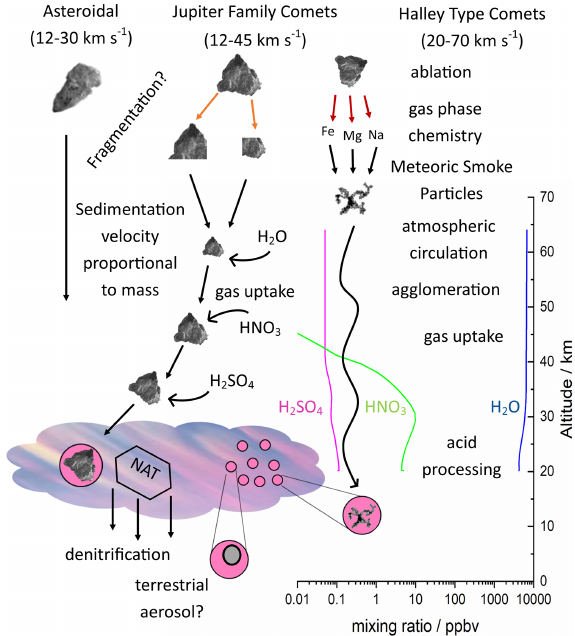
Figure 1. Possible pathways (black arrows) for meteoric material through the atmosphere. Brackets show the limits of entry velocity. Types of aerosol and processes affecting them are shown. Altitudes and concentrations are indicative of approximately where each pro- cess is important. See text for detailed